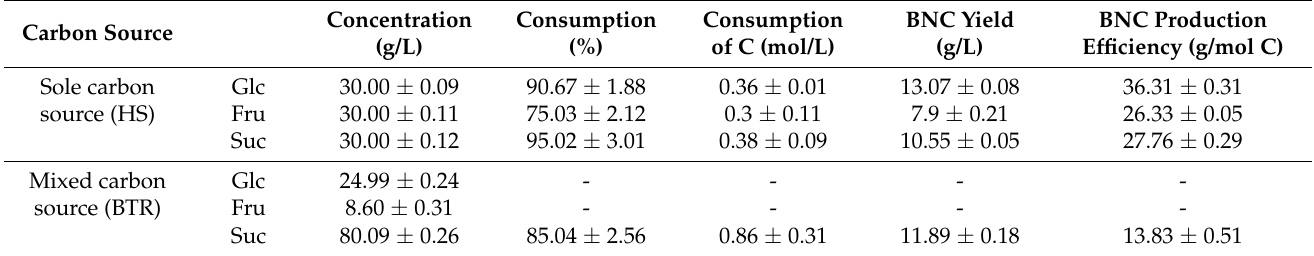
Table 3. BNC productivity in fermentations with different carbon sources.